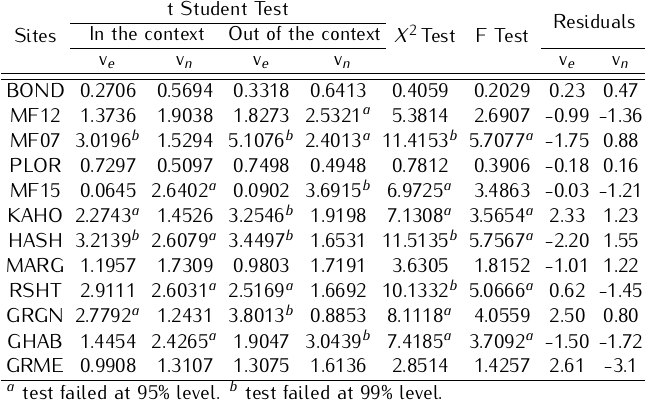
Table 9. Tests results (block B10). The results of the statistical tests for the GPS site data components. The sites passed from all the tests are the accepted data. The tests have been performed in two confidence levels (95% and 99%).